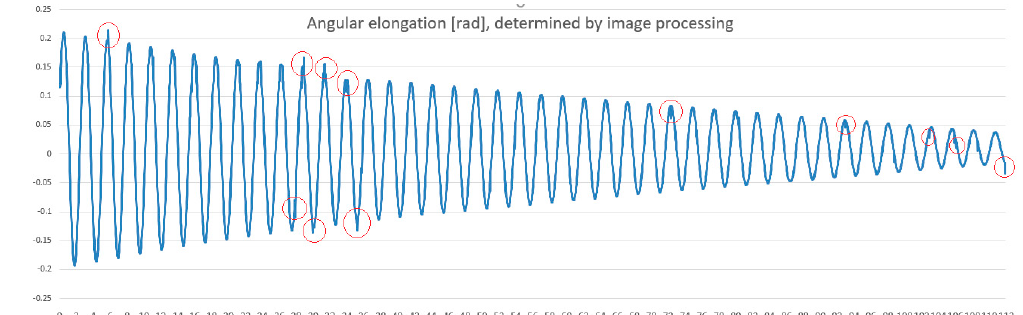
Figure 12. Plot of the angular elongation variation versus time as resulted in the first stage of image processing program elaboration.